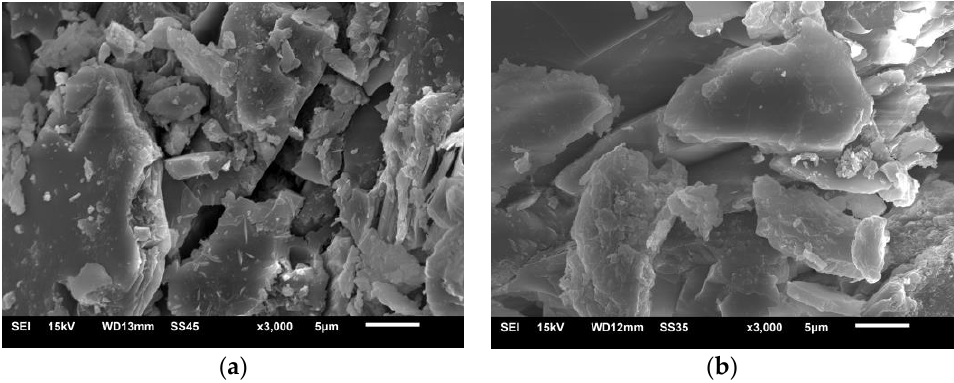
Figure 9. The SEM images of aggregate in concrete microbars cured in different alkali solutions at 80 °C: ( a ) 1 mol/L NaOH; ( b ) 1mol/L NaOH and 2 mol/L LiNO 3 .